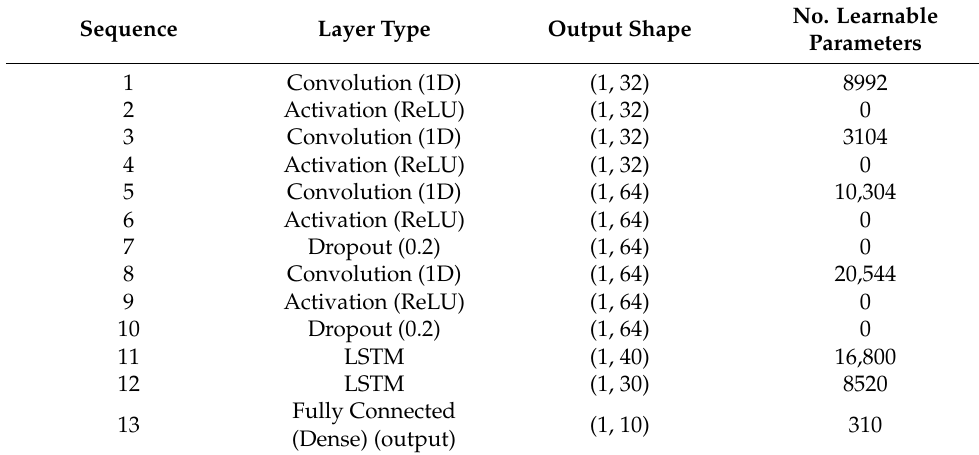
Table 1. Deep learning first model layers’ architecture.